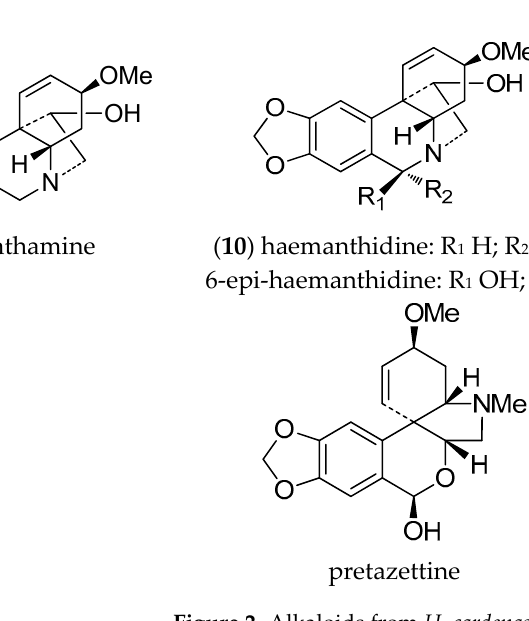
Figure 2. Alkaloids from H. cardenasianus .